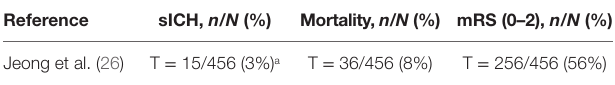
taBLe 8 | Outcomes of included studies investigating combined antithrombotic treatments use in patients with ischemic stroke who underwent acute mechanical